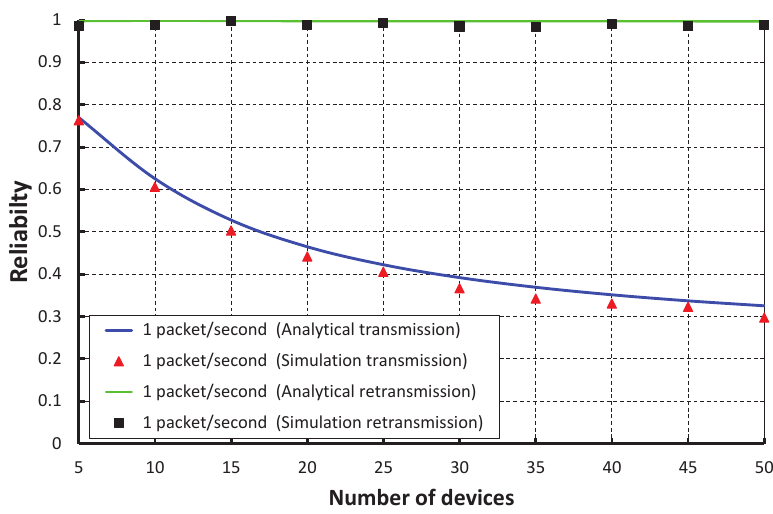
Figure 13. Validation of the reliability of our proposed scheme for different numbers of devices.